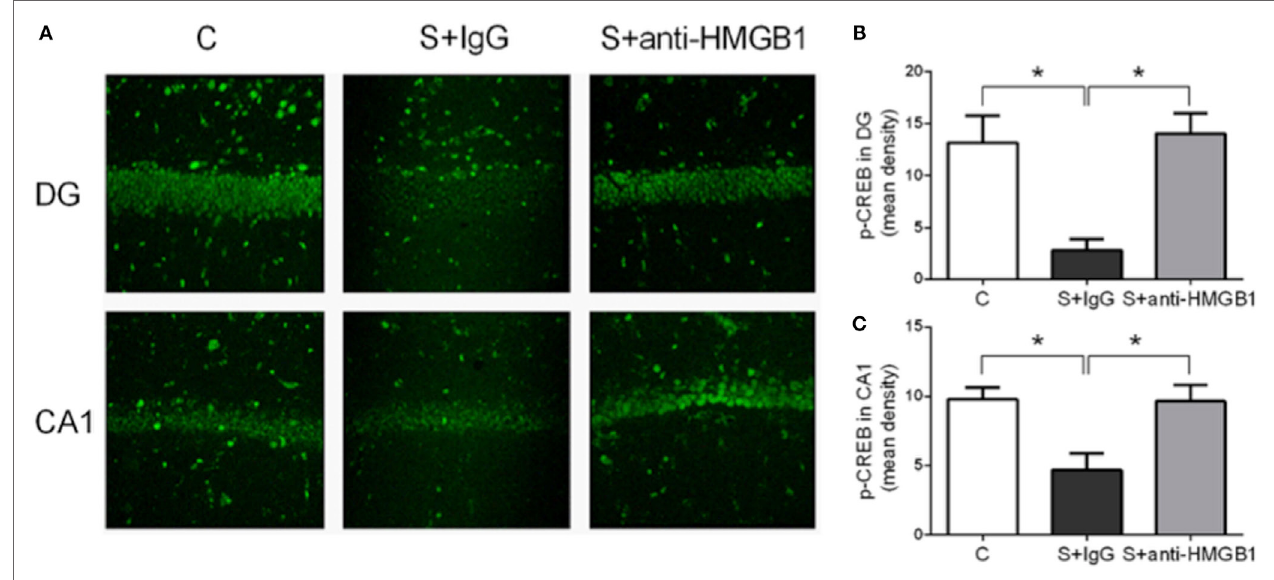
FigUre 2 | Modulation of p-creB by anti-hMgB1 . Representative p-CREB immunofluorescence in the hippocampus, DG and CA1 areas, on postoperative day 3 (a) . Expression of p-CREB was reduced after surgery (S + IgG), and anti-HMGB1 treatment was effective in rescuing the expression back to levels similar to the levels of control animals. (B,c) show relative mean optical density for p-CREB staining in DG and CA1. Results are expressed as mean ± SEM ( n = 5). Abbreviations: C, control; S, surgery. Scale bar = 50 μ m.